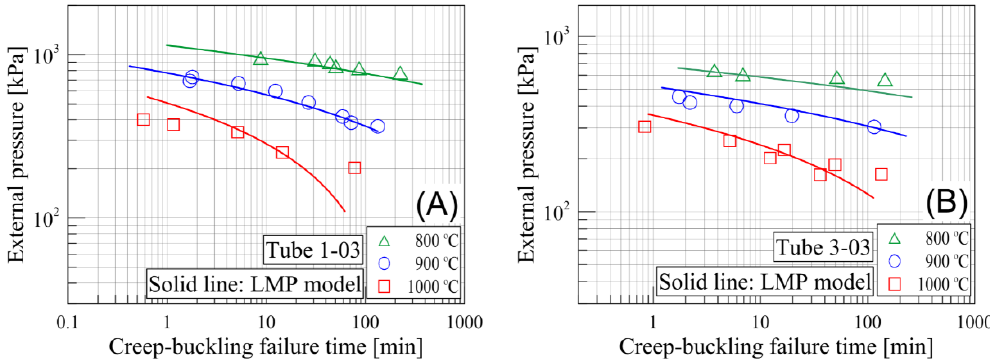
Figure 12. Prediction of the creep-buckling failure time using the LMP models (symbols: Experimental measurements) for ( A ) Tube 1-03 and ( B ) Tube 3-03.